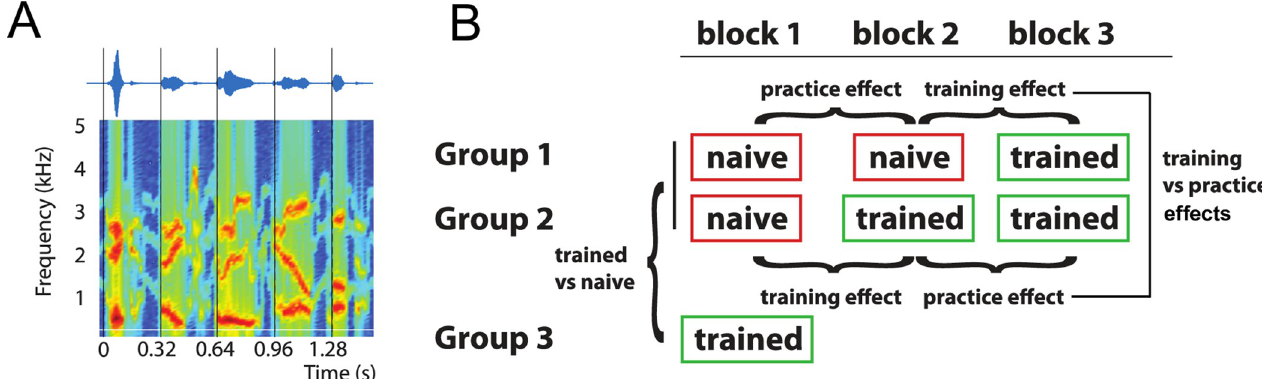
Fig 4. Stimuli and experimental design in Experiment 3. A. Sinusoids tracking the first three formants of the original speech (Fig 1A) signal were extracted and combined to form sine-wave speech (see Experiment 3, Materials). B. Three participant groups were trained to perceive the stimulus as speech at different points throughout the experiment (see Experiment 3, Procedure), and we tested how the induced change in perception affected their ability to detect irregularities in the stimulus rhythm. Groups 1 and 2 completed three experimental blocks and were na ï ve in block 1. Performance in the block immediately following the training, relative to that preceding the training, was defined as the training effect. Performance changes between the two blocks not interrupted by training was defined as the practice effect. Training and practice effects were then compared within and between groups (cf. Fig 6B). Group 3 was trained prior to the experiment and completed only one experimental block. Irregularity detection performance in this group was compared with performance in the other two groups, which were still na ï ve in block 1 (between-subject